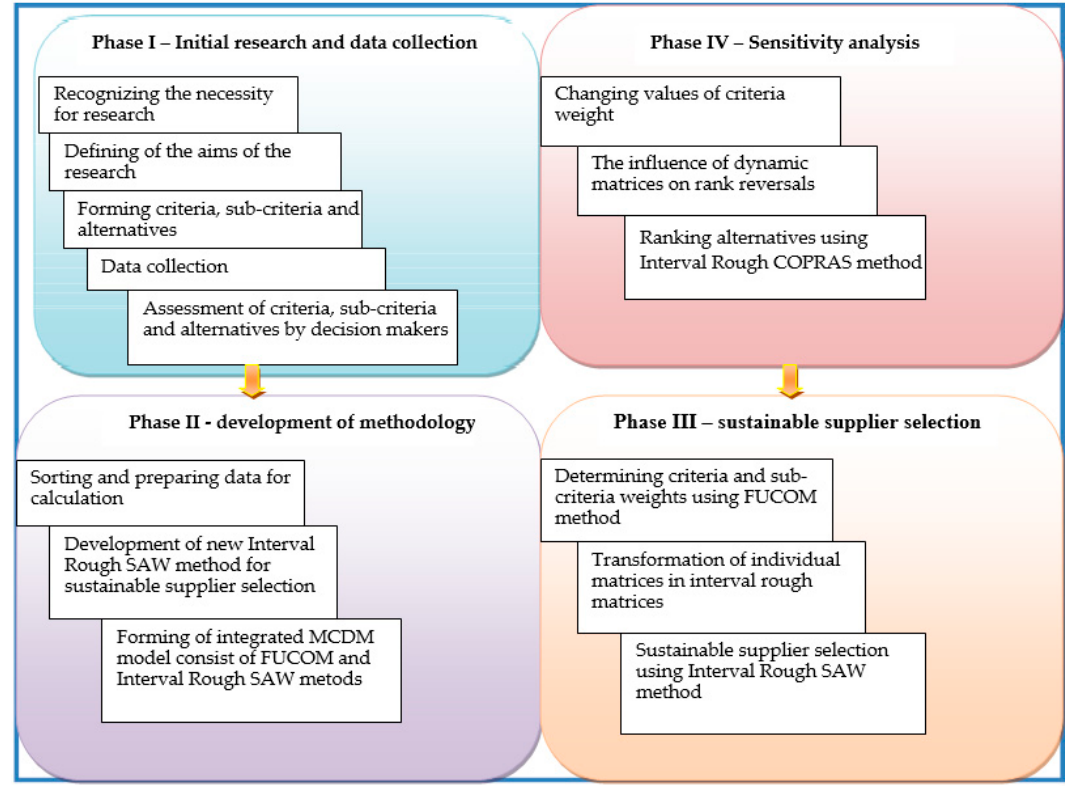
Figure 1. Proposed methodology.